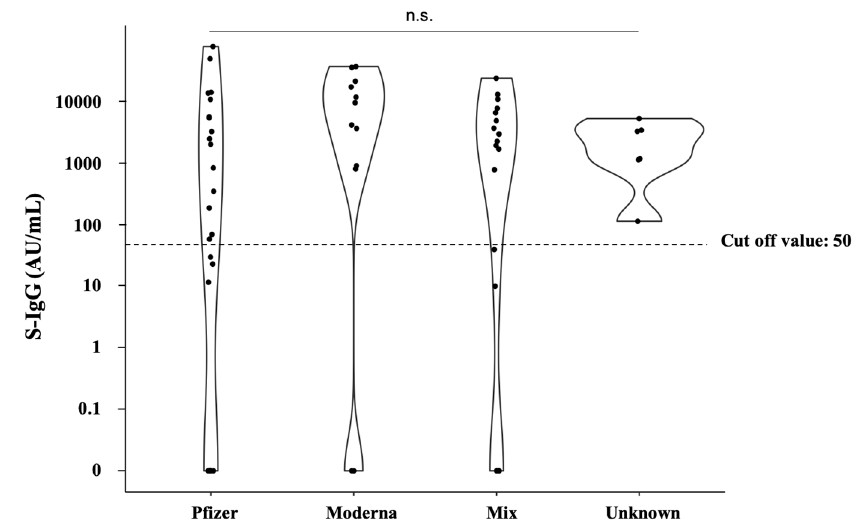
Figure 2. Comparison of S-IgG titers by vaccine type after the third vaccination. The dots indicate the values of SARS-CoV-2 spike-IgG antibodies. The dotted line indicates the cutoff value.